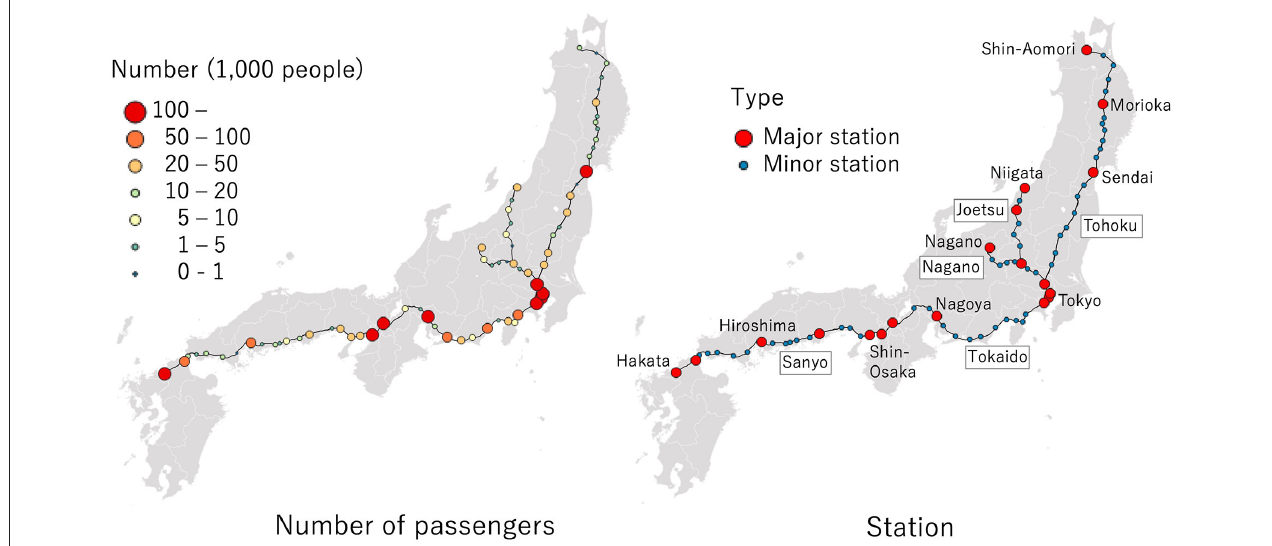
FIGURE 3 | Study area and the high-speed rail network. The major stations and other stations are shown in the right panel while the number of passengers is shown in the left. In the right panel, route names are surrounded by black border while station names are not. The major stations are considered as the nodes of the global network while all the stations are considered as the nodes of the local network.